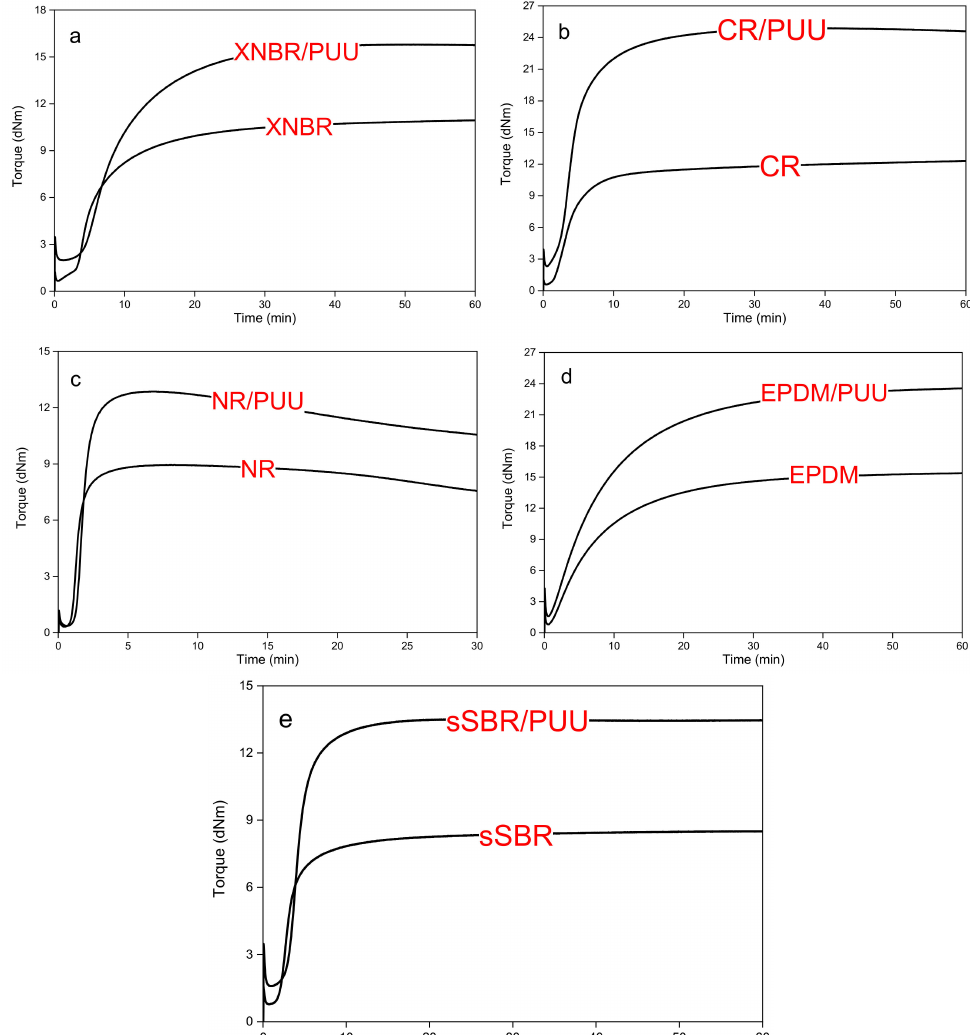
Figure 2. Vulcameter curves of blends are compared with the corresponding neat rubbers: ( a ) XNBR and XNBR/PUU; ( b ) CR and CR/PUU; ( c ) NR and NR/PUU; ( d ) EPDM and EPDM/PUU and ( e ) sSBR and